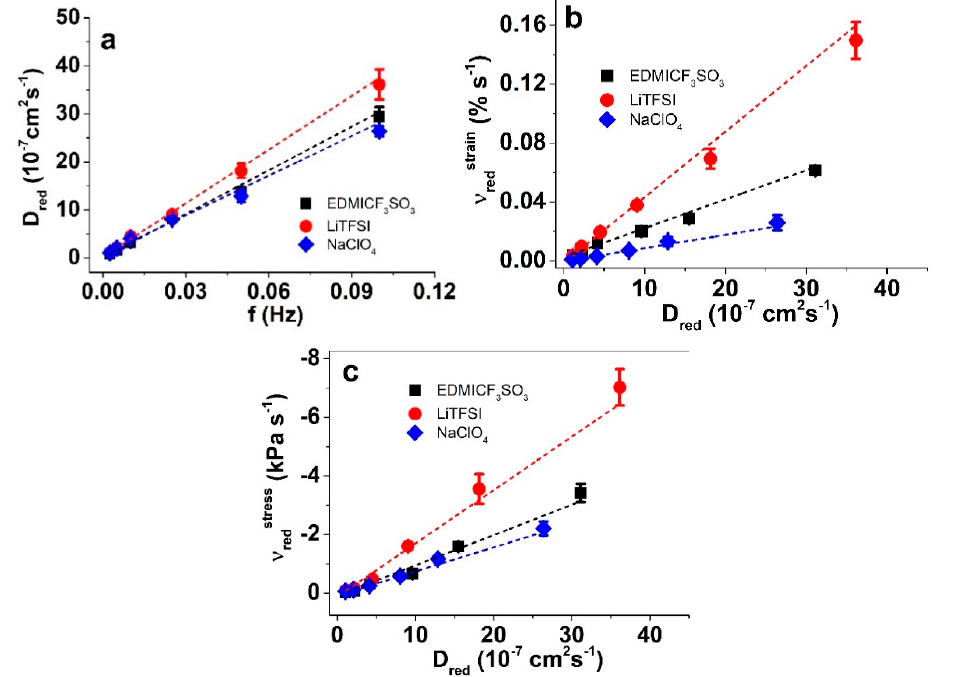
Figure 6. ( a ) diffusion coefficients vs. frequency upon reduction in PP–IPN trilayers in EDMICF 3 SO 3 Figure 6. ( a ) di ff usion coe ffi cients vs. frequency upon reduction in PP–IPN trilayers in EDMICF 3 SO 3 ( ■ , black), LiTFSI ( ● , red) and NaClO 4 ( ♦ , blue) solutions. The strain rate ν redstrain in ( b ) and the stress ( (cid:4) , black), LiTFSI ( (cid:8) , red) and NaClO 4 ( (cid:7) , blue) solutions. The strain rate ν redstrain in ( b ) and the stress rate ν redstress in ( c ) against the diffusion coefficients upon reduction. The dashed lines symbolize the rate ν redstress in ( c ) against the di ff usion coe ffi cients upon reduction. The dashed lines symbolize the linear fits and are shown as visual guides. linear fits and are shown as visual